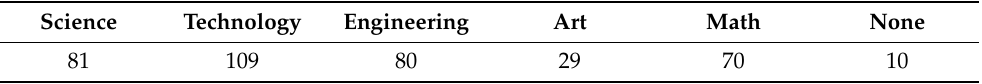
Table 3. STEAM content area prevalence. The number of initiatives focused on each content area. Since many initiatives are multidisciplinary, the total is greater than the number of initiatives. Science Technology Engineering